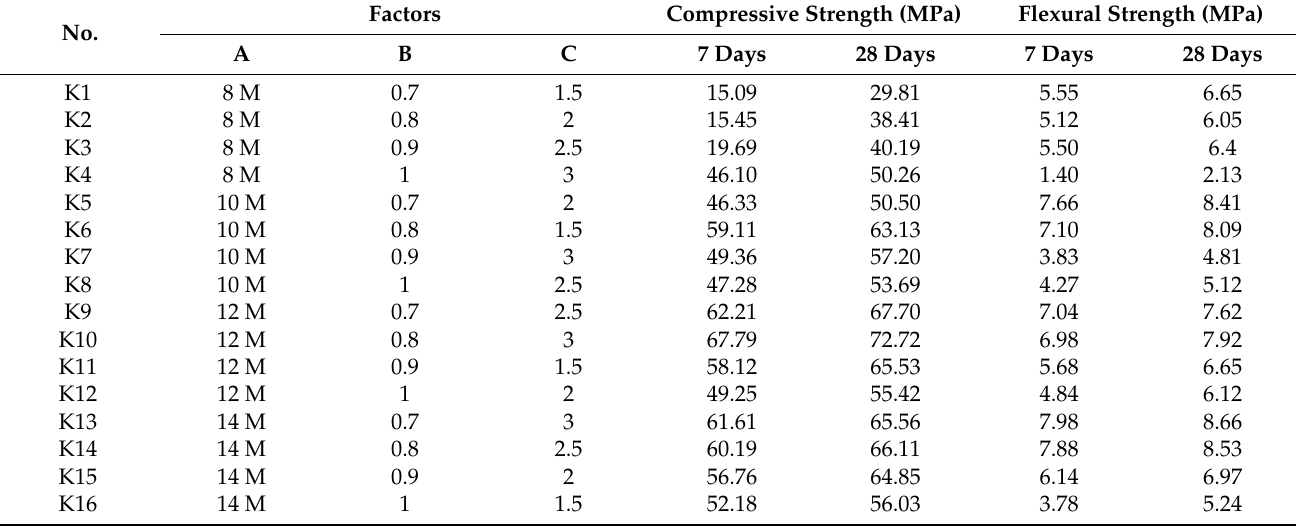
Table 4. The 7-day and 28-day compressive and flexural strengths of the K-based